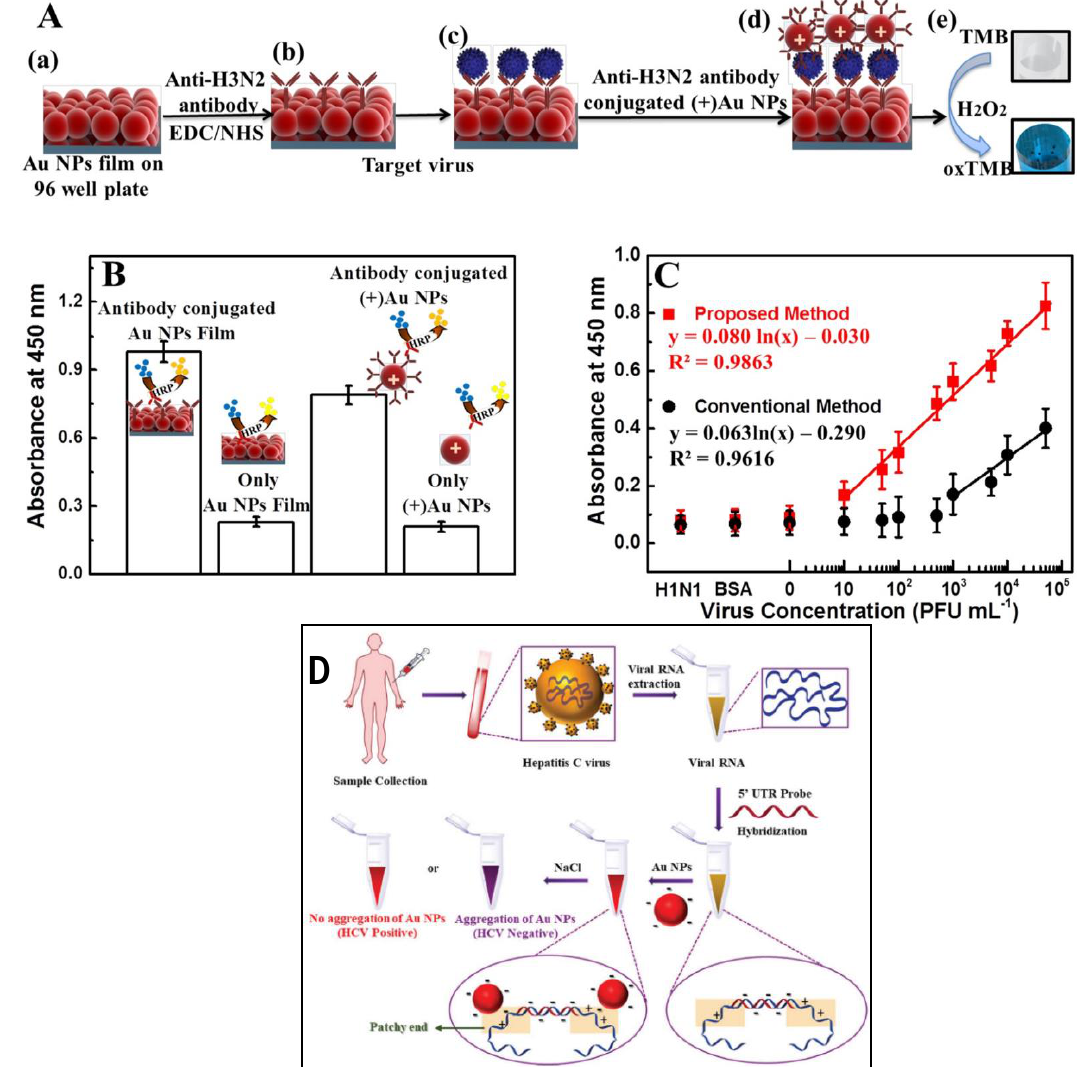
Figure 3. Design and detection of Influenza virus A (New Caledonia/20/1999) (H1N1) was discovered on film. ( A ) Virus detection schematic: ( a ) AuNP films on 96-well polystyrene plates; ( b ) anti-HA antibody immobilization on AuNPs using EDC/NHS chemistry. ( c ) The target virus was introduced after washing the NPs (n = 3) and incubated at room temperature for 30 min. ( d ) The virus was bound by the anti-NA antibody-conjugated (+)AuNPs via an antibody-antigen reaction, and the unbound (+)AuNPs washed away. ( e ) TMB-H2O2 was added, and the oxidation of the peroxidase substrate TMB resulted in fast color shifts (oxTMB). ( B ) Anti-NA antibody binding to (+)AuNPs via electrostatic interactions as determined by ELISA. ( C ) The absorbance calibration curve for the influenza virus A concentration (New Caledonia/20/1999) (H1N1). H3N2-donated influenza virus A/Yokohama/110/2009 (H3N2) was used to test the system’s specificity (n = 3) (adapted with permission from Ahmed et al., Scientific Reports, 2017 [156]). ( D ) Representation of the AuNP-based assay strategy for HCV viral RNA sensing in clinical samples (adapted with permission from Mohammad et al., Analyst, 2021